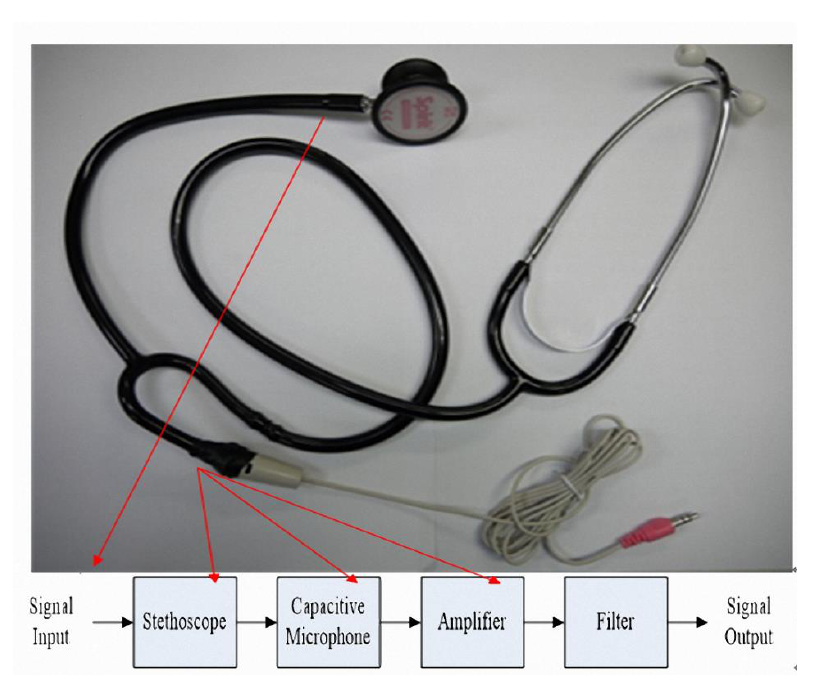
Figure 6. Modified microphone stethoscope .